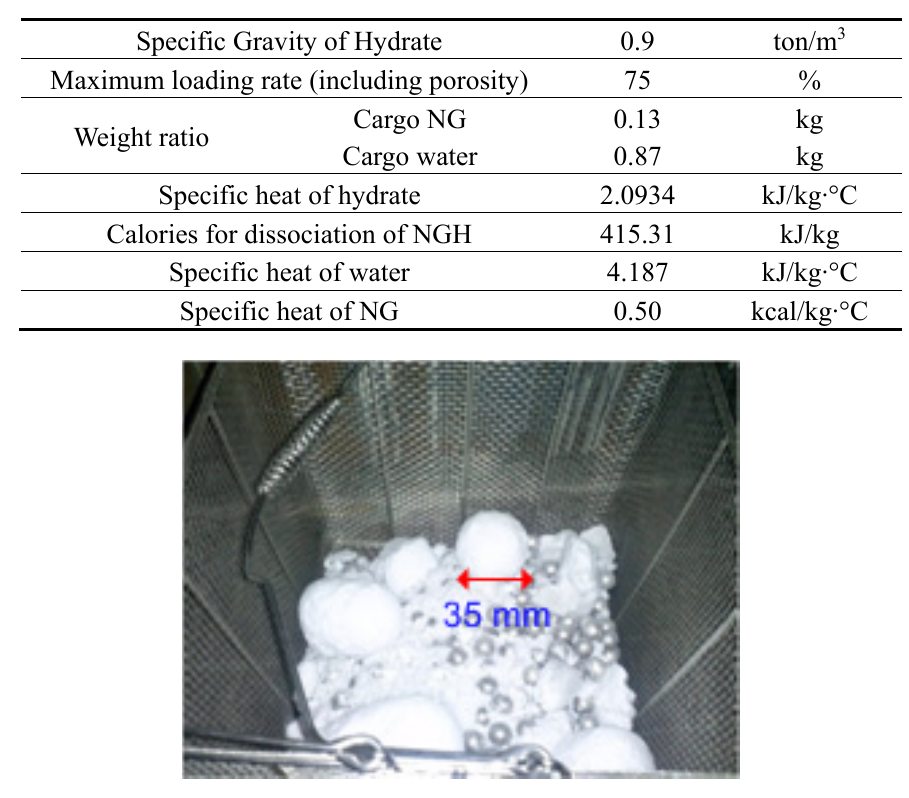
Figure 1. Appearance of ball-type NGH pellets (courtesy of Dongguk University, Korea).